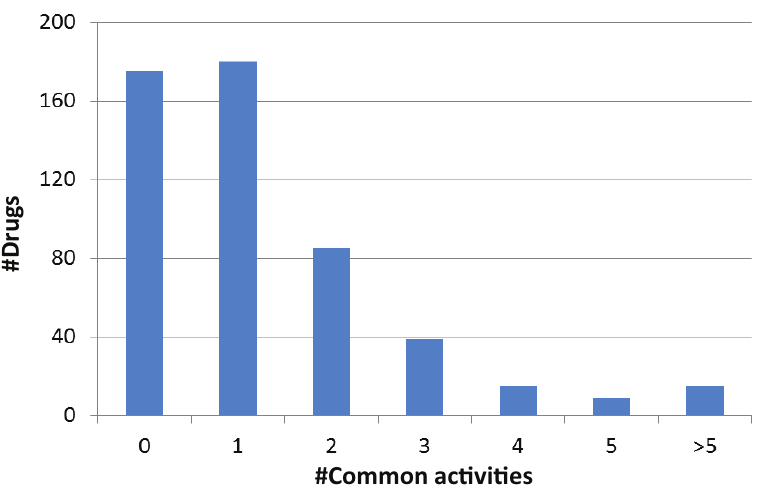
Figure 4. Comparison of activity profiles in DrugBank and ChEMBL. The activity profiles of 518 drugs in DrugBank and ChEMBL are compared. Reported is the number of drugs sharing increasing numbers of activities (#Common activities) in the two databases.